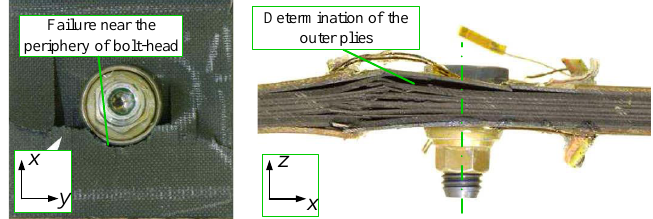
Figure 11. Some failure modes of FHC test (Reproduced from Reference [16]).